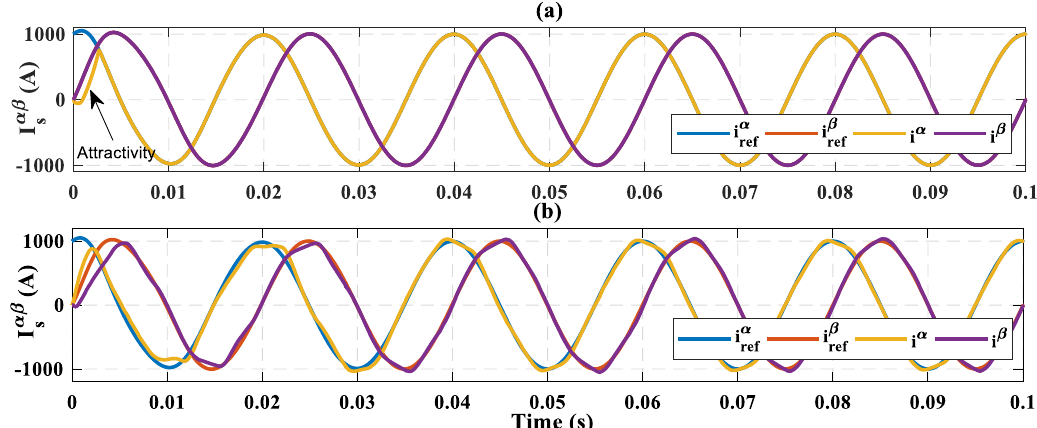
Figure 9. Output current in αβ -axis and its references; ( a ) control using sliding mode control (SMC); ( b ) control using proportional resonant (PR).